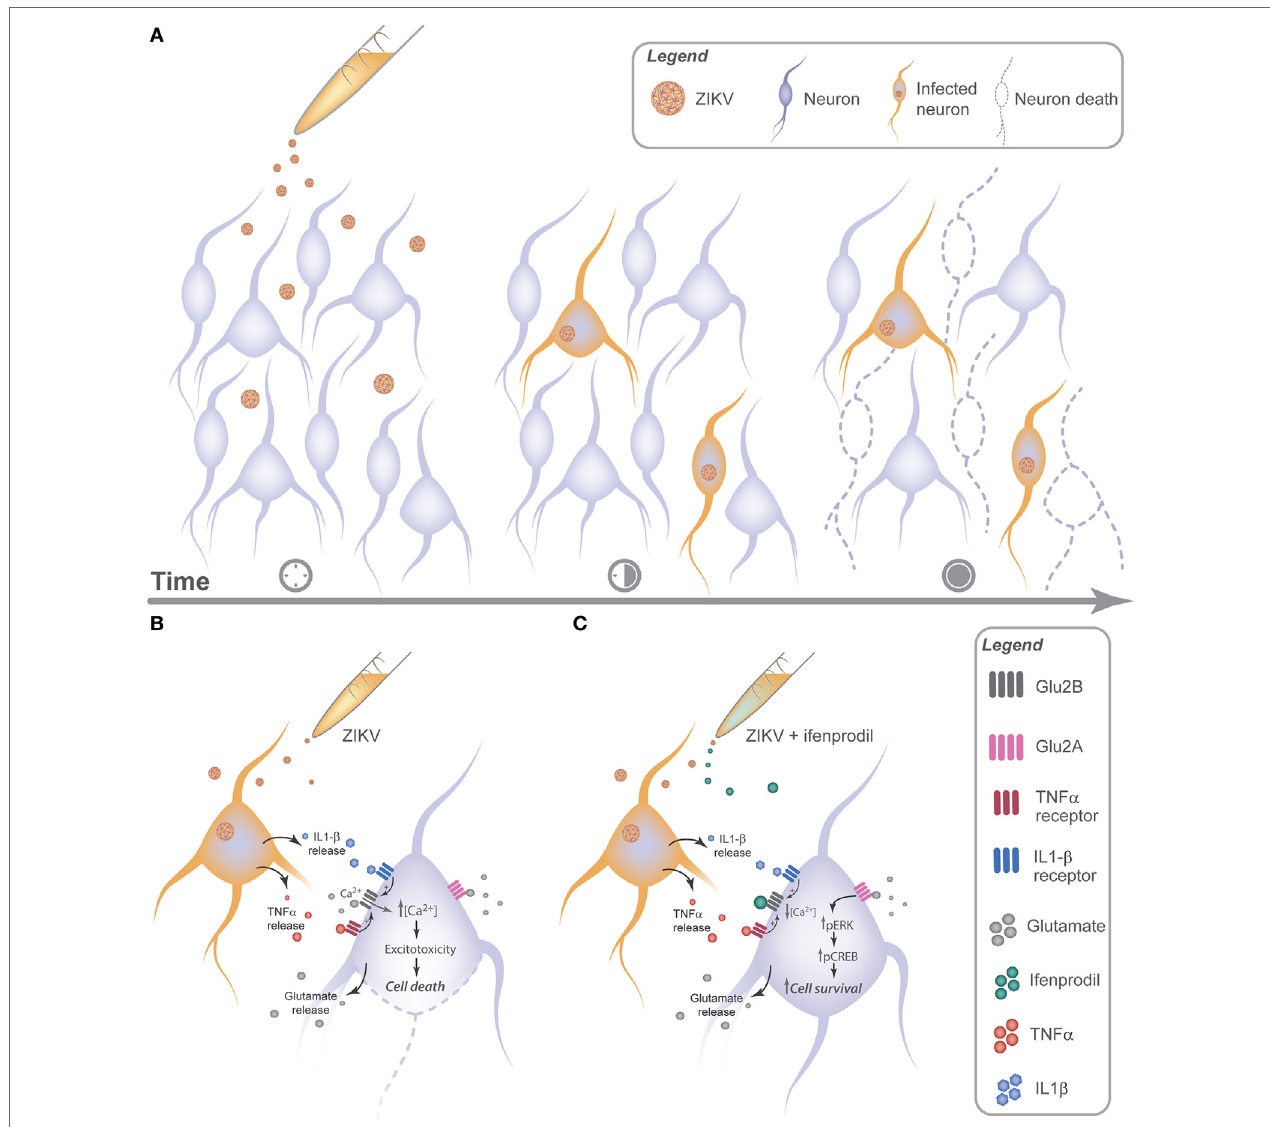
FigUre 7 | Zika virus (ZIKV) promotes neuronal cell death via GluN2B activation in a non-cell autonomous manner by releasing neurotoxic factors. (a) ZIKV can be detected as early as 12 h following viral infection. 24 h later, cell injury can be observed in uninfected neurons nearby infected cells, indicating a cross talk between infected and uninfected neurons. (B) Neuronal cultures infected with ZIKV release glutamate and cytokines, triggering GluN2B-containing N -methyl- d -aspartate receptor (NMDAR) sensitization and increasing the influx of extracellular Ca 2 + , which facilitates excitotoxicity. (c) Ifenprodil treatment of ZIKV-infected cultures reduces viral-mediated increased Ca 2 + flux through GluN2B-containing NMDARs. Activation of GluN2A-containing NMDARs by glutamate in the presence of ifenprodil leads to ERK and CREB activation, which can increase the expression of genes important for neuronal survival.